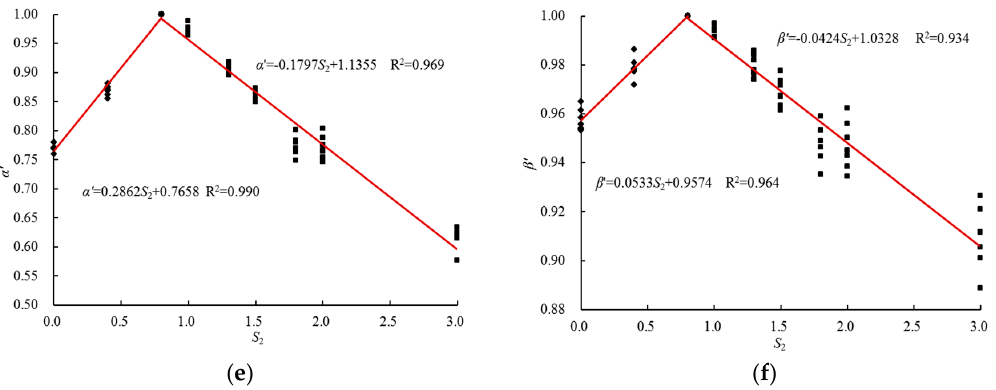
Figure 6. Variation of dimensionless parameters for different slope coefficients: ( a ) α ; ( b ) β ; ( c ) α max ; ( d ) β max ; ( e ) α ′ ; ( f ) β ′ .